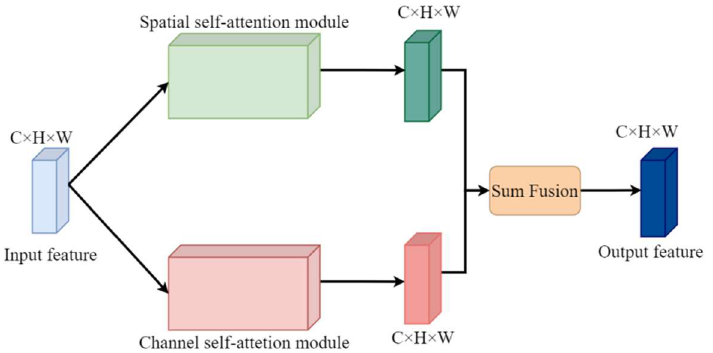
Figure 5. The principle diagram of DSAM.